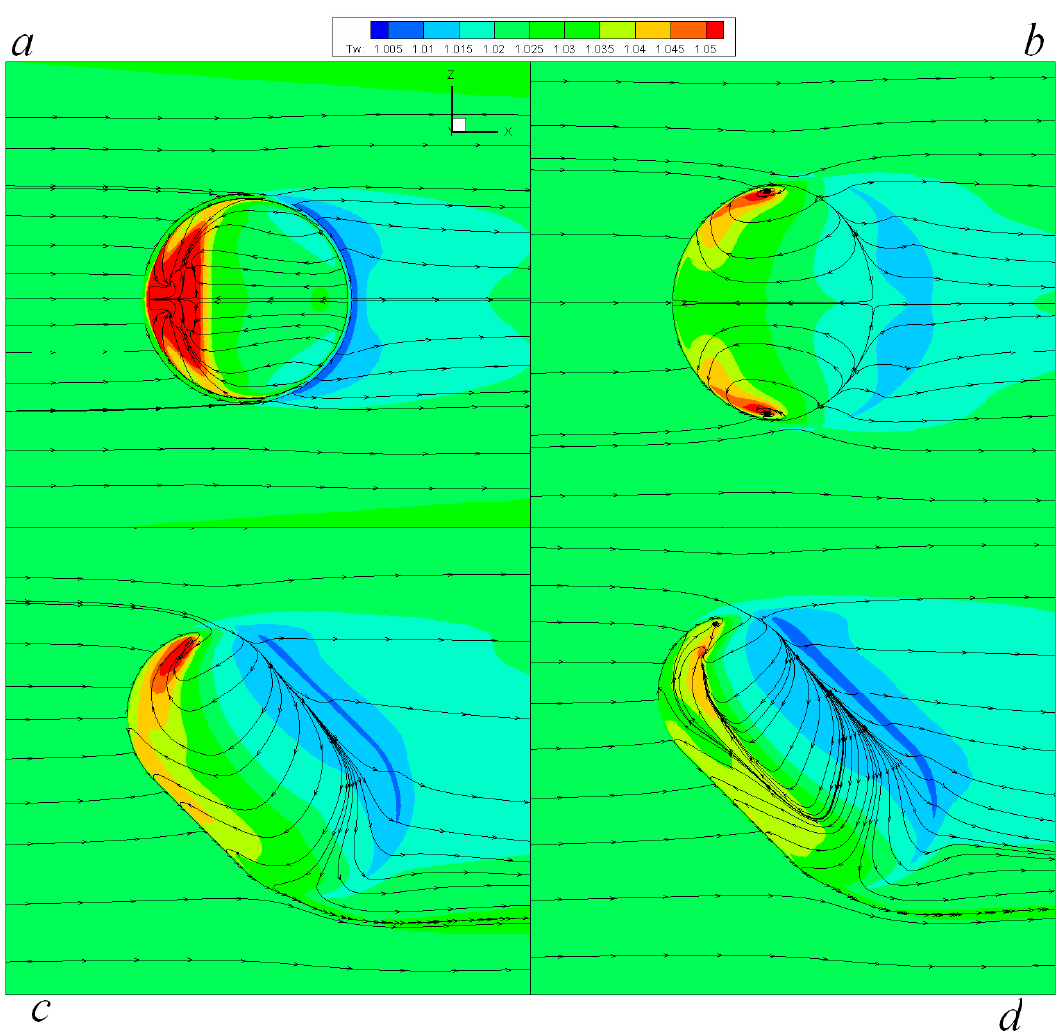
Figure 12. Temperature fields at the heated wall with conical ( a ) and oval dimples of width 1 ( b ), 0.731 ( c ), 0.678 ( d ) and the streamlines.